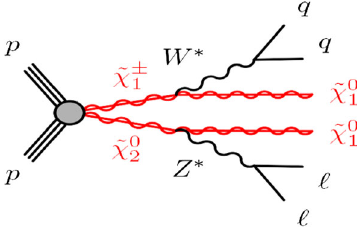
Fig. 11 The schematic diagram of the production process pp → ˜ χ ± ˜ χ 0 with the sequent decays ˜ χ 0 1 2